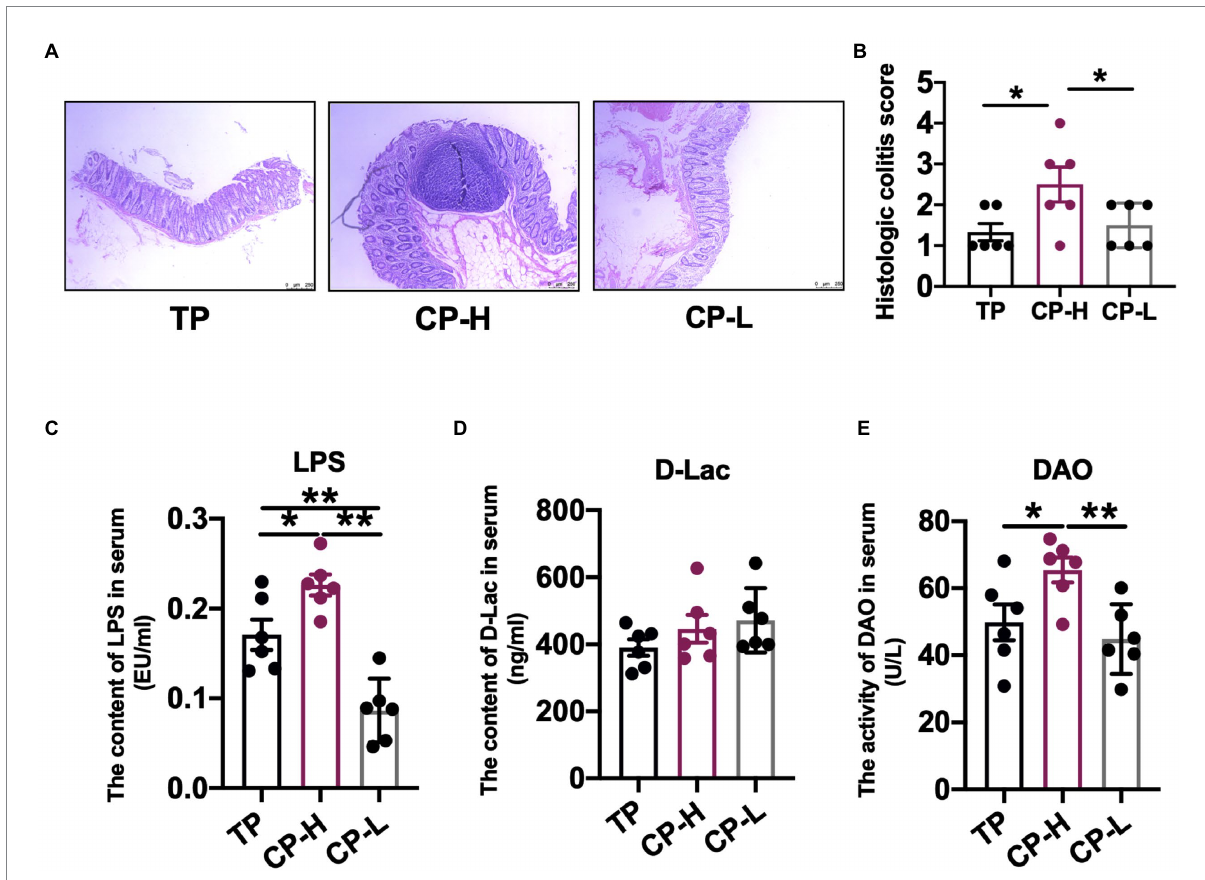
FIGURE 1 Effects of high-altitude hypoxic environment on intestinal tissue and LPS, DAO and D-lactide in serum of pig. TP: positive control group, CP-H: treatment group, CP-L: negative control group. (A) HE-stained pathological sections of colonic tissue from pigs of groups. (B) Histologic colitis score of pigs. (C) The content of LPS in serum of pigs. (D) The content of D-Lac in serum of pig. (E) The activity of DAO in serum of pigs. Data are expressed as mean ± SEM ( n = 6). * indicating a statistically significant difference ( p < 0.05), ** indicating a highly significant difference ( p <